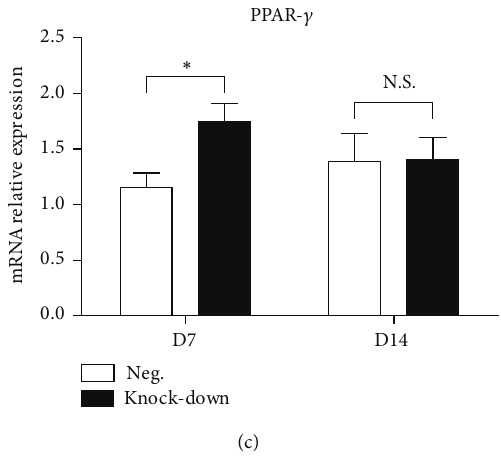
Figure 4: Osteogenic and adipogenic differentiation of transfected BM-MSCs. (a) Osteogenic differentiation of transfected BM-MSCs was detected by Alizarin Red staining. Scale bar = 100 𝜇 m. (b) Adipogenic differentiation of transfected BM-MSCs was demonstrated via Oil red O staining. Scale bar = 100 𝜇 m. (c) Mean relative values ( ± SD) of ALPL , BSP , RUNX2 , LPL , and PPAR- 𝛾 mRNA expression in Day 7 and Day 14 of induction culture